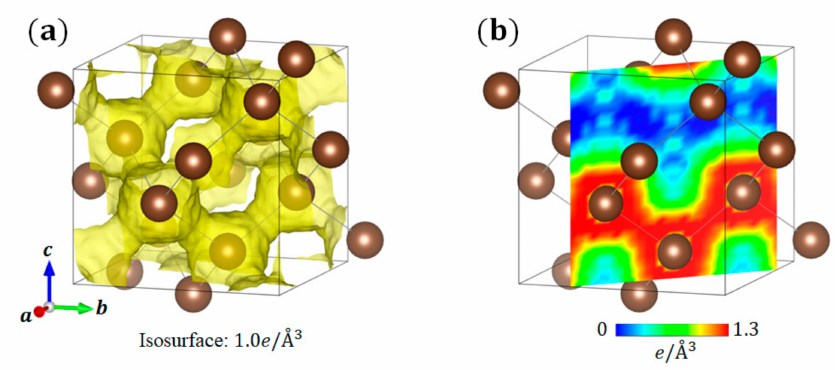
Figure 3. Valence electron density (VED) distribution of diamond calculated by the CDFS method using Equation (7): ( a ) Surface plot, and ( b ) Sectional view of the (4 4 0)